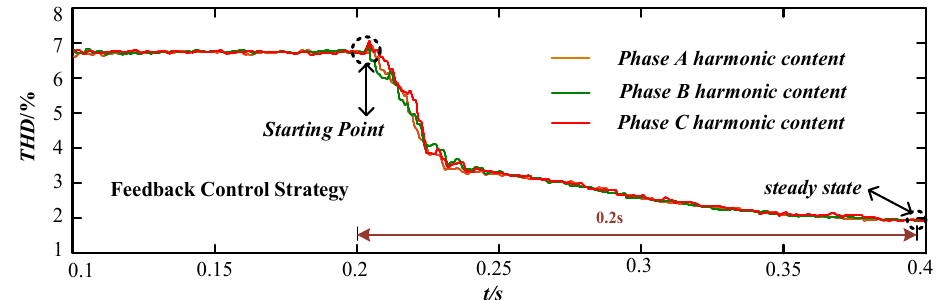
Micromachines 2022 , 13 , x FOR PEER REVIEW Figure 8. The harmonic change under the voltage feedback control strategy. Figure 8. The harmonic change under the voltage feedback control strategy.